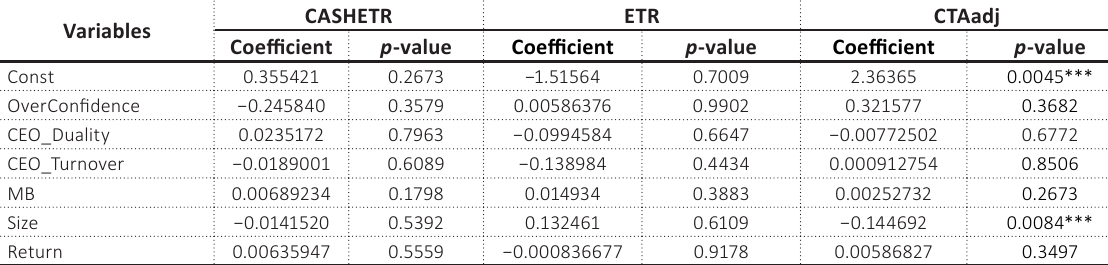
Table 8. Duality and